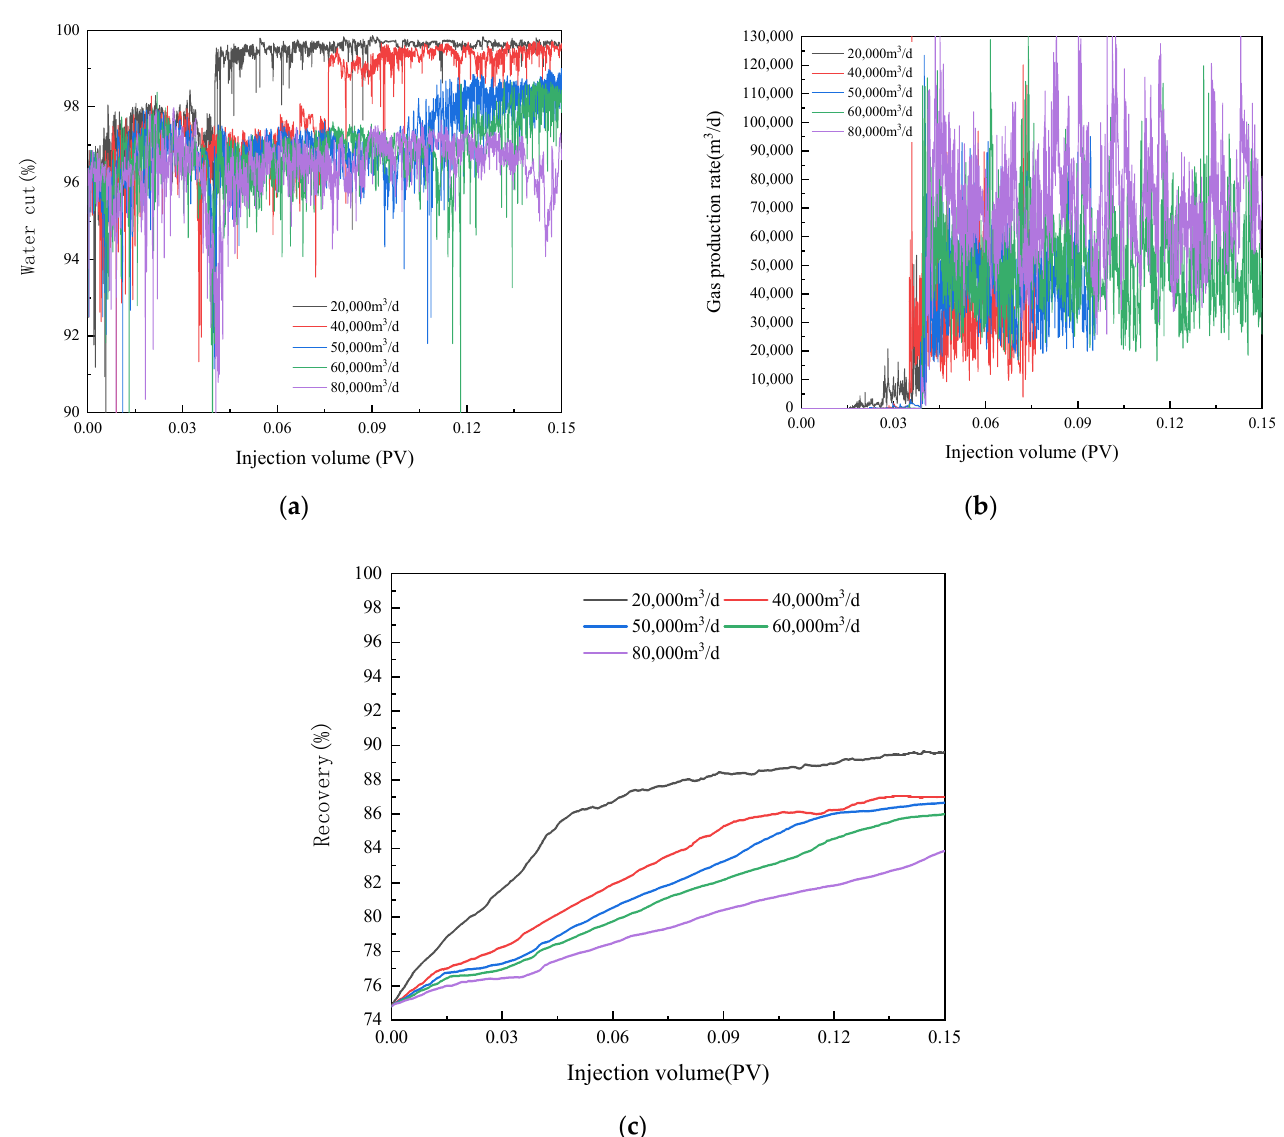
Figure 10. Production curves under different flow rate: ( a ) water cut; ( b ) gas production rate; ( c ) cumulative recovery.